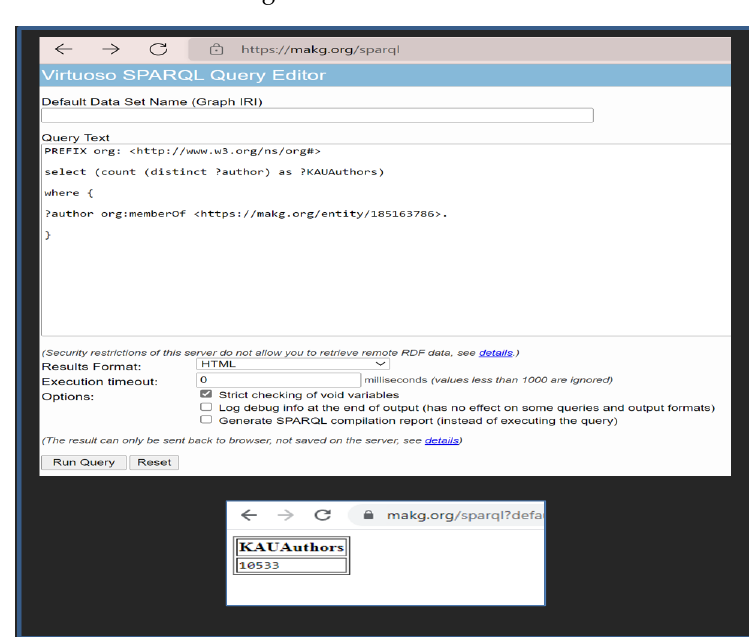
Figure 2. Count KAU researchers ’ profiles in MAKG.